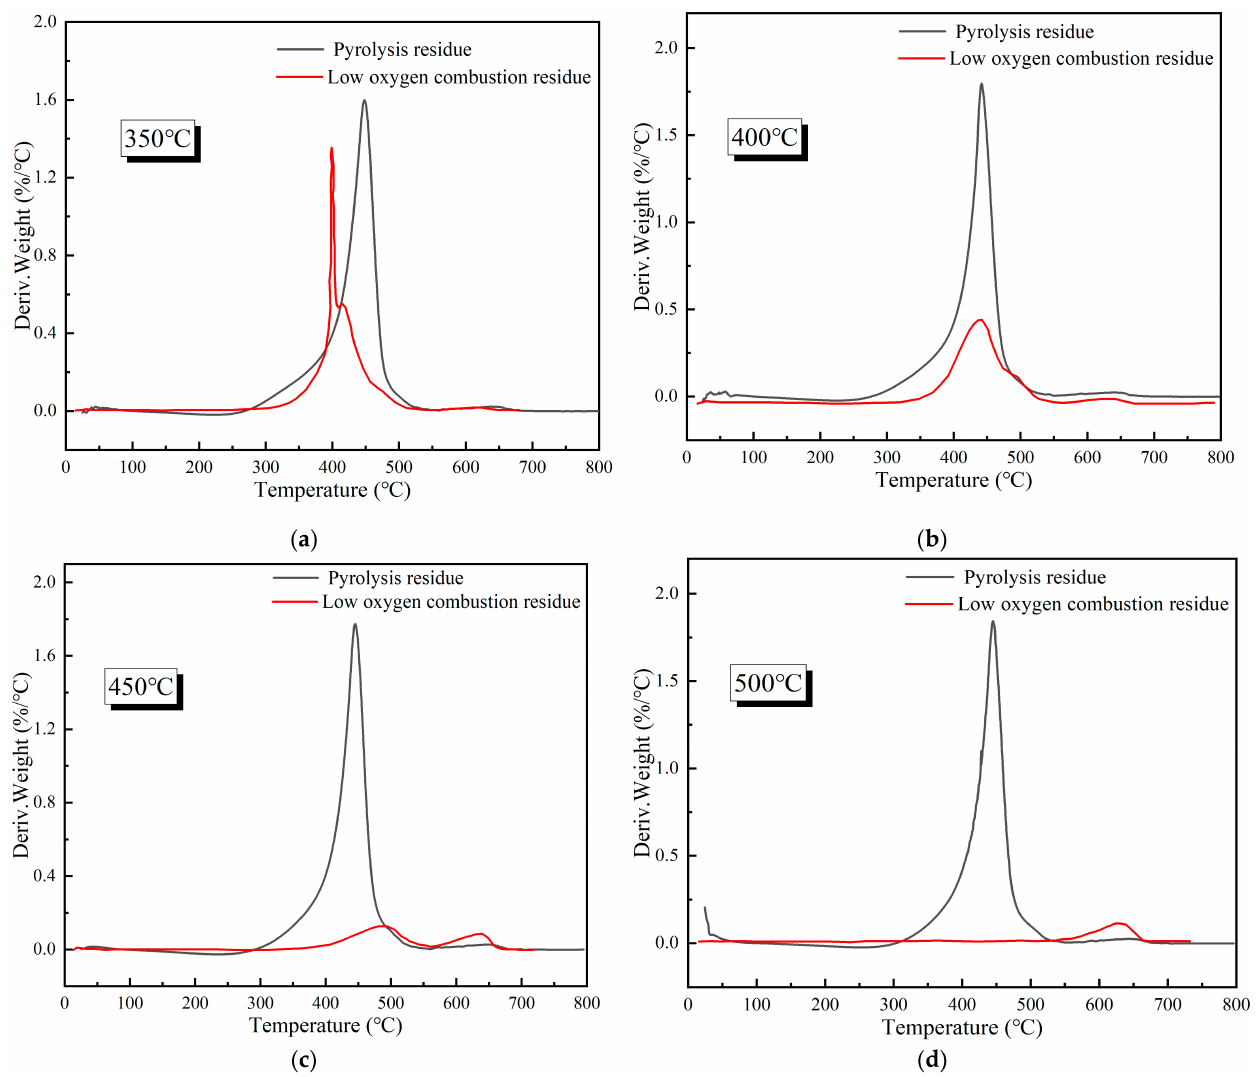
Figure 6. DTG curve of the residues of pyrolysis and low oxygen combustion in different constant temperatures. ( a ) The constant temperature is 350 ◦ C, ( b ) the constant temperature is 400 ◦ C, ( c ) the constant temperature is 450 ◦ C, and ( d ) the constant temperature is 500 ◦